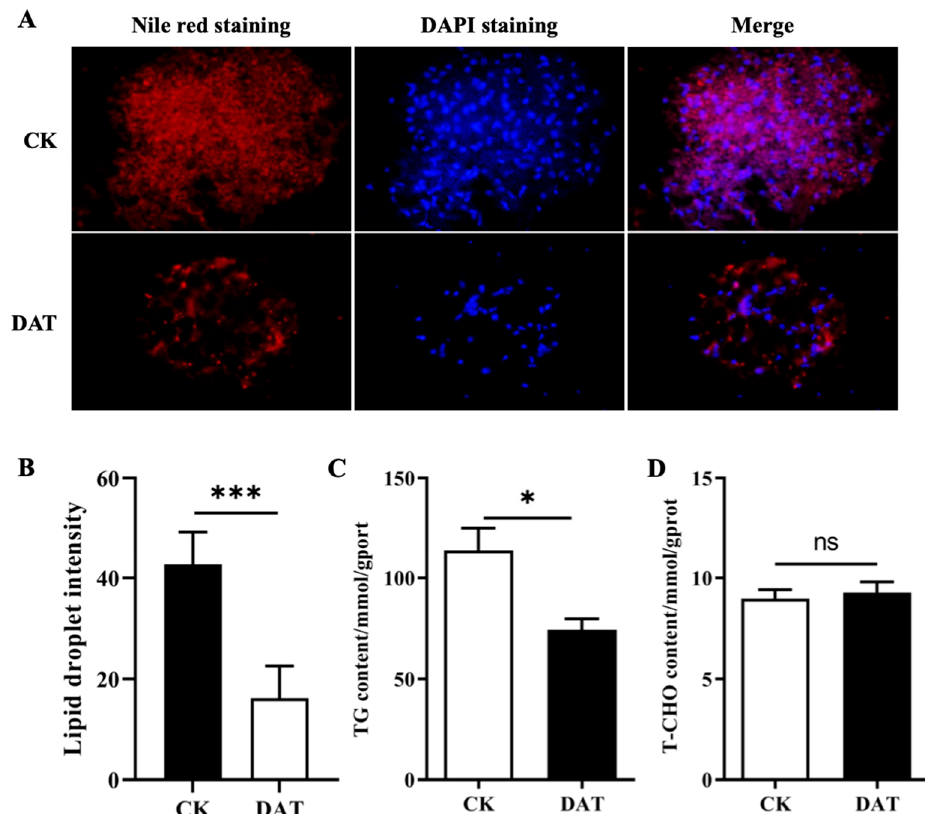
Figure 5. Lipid droplets and triacylglycerol characterization. ( A , B ) Characterization of lipid droplets in the fat bodies of control and DAT-fumigated adult male moths. Fat bodies of adult male moths were dissected and stained by Nile red and nuclei in the fat bodies were stained by 40,6-diamidino- 2-phenylindole (DAPI), shown as red and blue fluorescence. The (CK) marks the control group, showing strong fluorescence of lipid droplets. Tight arrangement of lipid droplets’ grooves-like structures are evident in fat bodies. The (DAT) indicates the lipid droplets in the fat bodies from DAT-fumigated moths. Weak fluorescence, empty spaces and small sizes indicated. ( C ) Determination of triacylglycerol content from the fat bodies of male adult moths of control and DAT-fumigated groups. The DAT fumigation significantly reduced the triacylglycerol contents in the adult-male-moth fat bodies. ( D ) Total cholesterol content from the fat bodies of male adult moths from control and DAT-fumigated groups. Control and DAT groups showed no significant difference in the quantification of cholesterol contents. Triacylglycerol contents (mmol triglyceride g − 1 total protein) and cholesterol content (mmol cholesterol g − 1 total protein) were determined from three independent biological replicates (mean ± standard deviation; n = 5). CK (control group), DAT (DAT-fumigated adult moths). Figure data expressed as mean ± SE; ns (non-significant difference), * p < 0.05 *** p < 0.001 ( t -test).